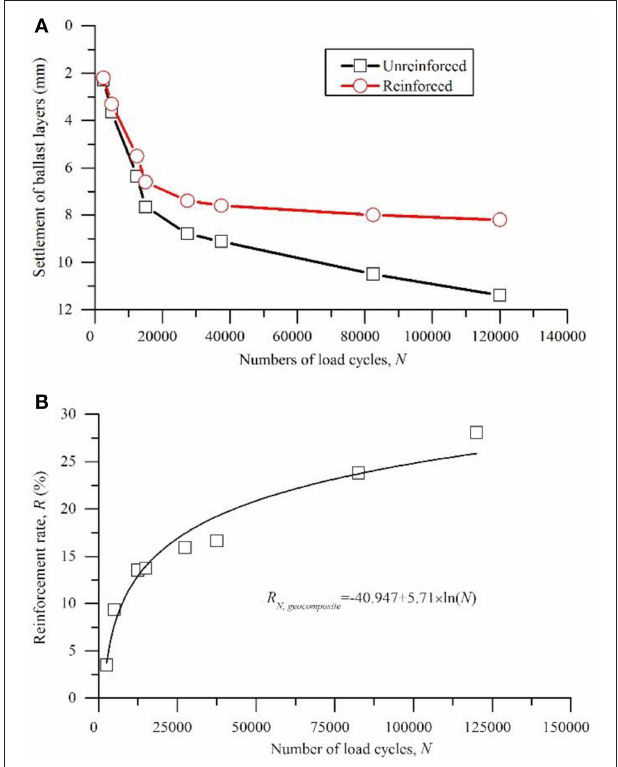
FIGURE 10 | Results of cyclic loading: (A) settlement of ballast layer over fair subgrade; (B) reinforcement rate of single and double layers of geogrids. FIGURE 11 | Measured settlement data of the fresh ballast sections at the site